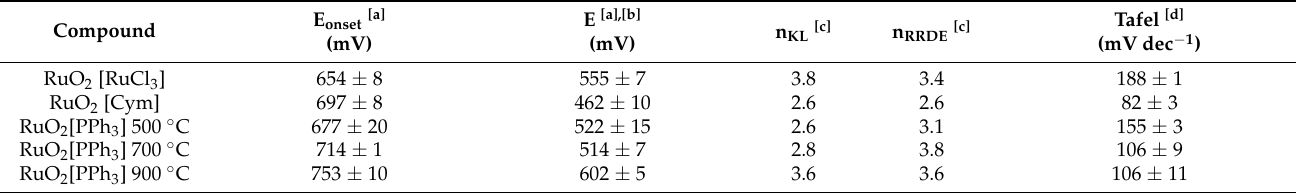
Table 1. Electrochemical parameters obtained from the data in Figure 5.